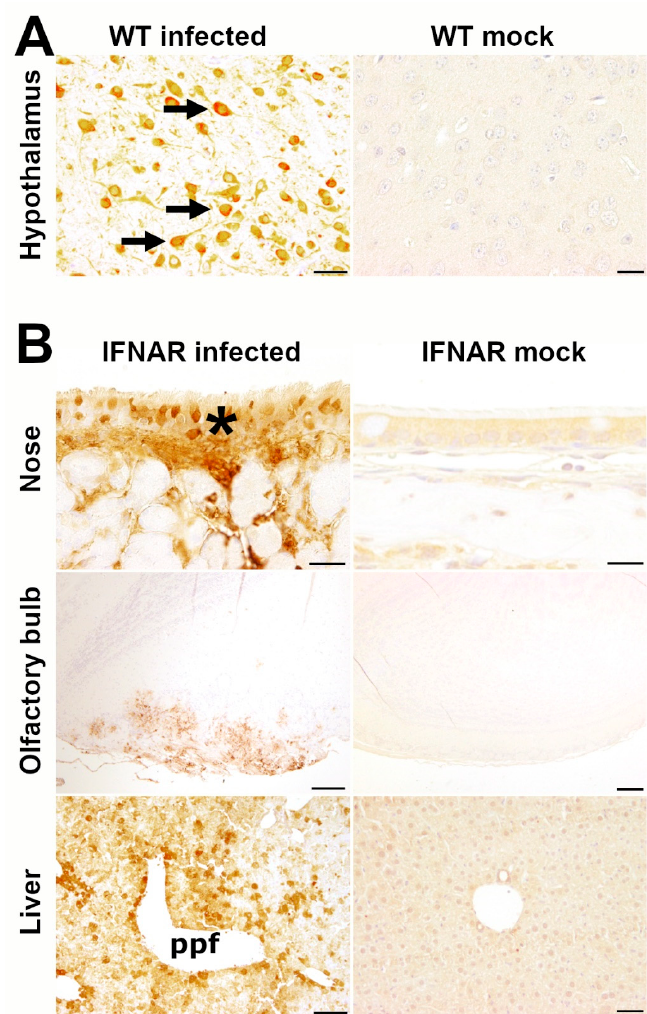
Figure 4. Rift Valley fever virus (RFVF) antigen in the hypothalamus of wild type (WT) mice ( A ) and nose, olfactory bulb and liver of type I interferon knockout (IFNAR − / − ) mice ( B ). Infected mice are shown in the left column and mock-infected control mice in the right column. RVFV antigen was found in hypothalamic neurons (arrows) of a WT mouse infected with 10 4 plaque-forming units (PFU) RVFV at 7 days post infection (dpi) as well as in the respiratory epithelium (asterisk) of the nose (5 dpi, same animal as in Figure 3), neurons of the olfactory bulb (2 dpi, same animal as in Figure 3) and hepatocytes (ppf: periportal field, 2 dpi) of IFNAR − / − mice infected with 10 3 PFU RVFV. Virus antigen was absent in all investigated organs of mock-infected control animals sampled at 21 dpi. Immunohistochemistry against RVFV nucleoprotein using the avidin-biotin-complex (ABC) method with 3,3 ′ -diaminobenzidine tetrahydrochloride (DAB) as chromogen. Bars: hypothalamus and nose = 20 µm; olfactory bulb = 100 µm; liver = 50 µm).